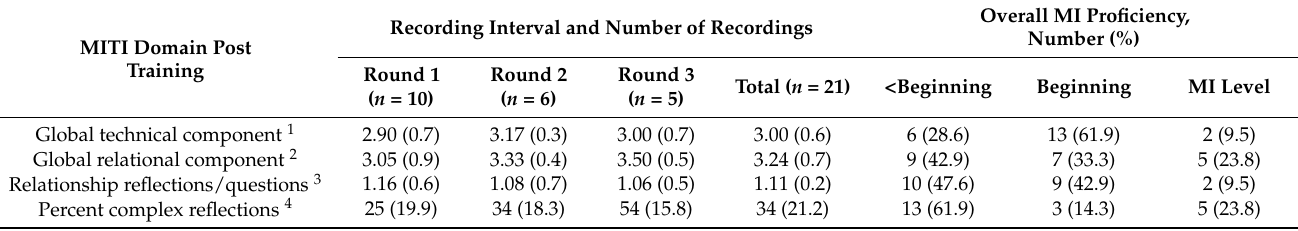
Table 2. Mean (standard deviation) of MITI 4 scores and motivational interviewing (MI) proficiency frequencies for 21 recordings across three consecutive rounds.